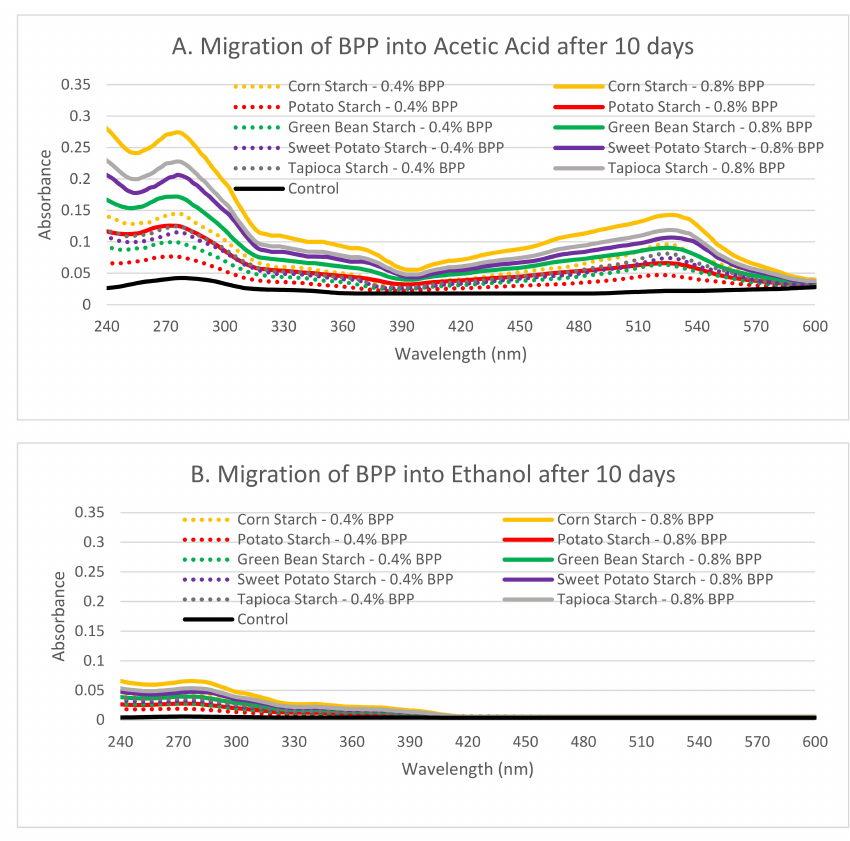
Figure 5. UV absorbance curves of the simulant solutions after extracting corn, potato, green bean, sweet potato and tapioca starch films with di ff erent contents of blueberry pomace (BP) in ( A ) acetic acid and ( B )